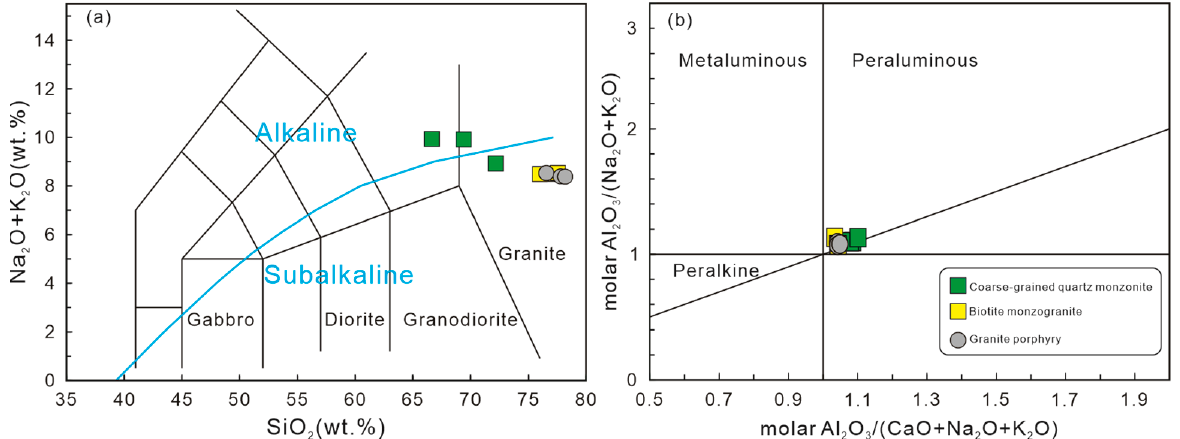
Figure 5. Diagrams of ( a ) Na 2 O + K 2 O vs. SiO 2 (TAS) and ( b ) A/NK [molar ratio Al 2 O 3 /(Na 2 O + K 2 O)] vs. A/CNK [molar ratio Al 2 O 3 /(CaO + Na 2 O + K 2 O)] for the coarse-grained quartz monzonite, biotite monzogranite, and granite porphyry samples from the Yushulinzi pluton in the Liaodong Peninsula.